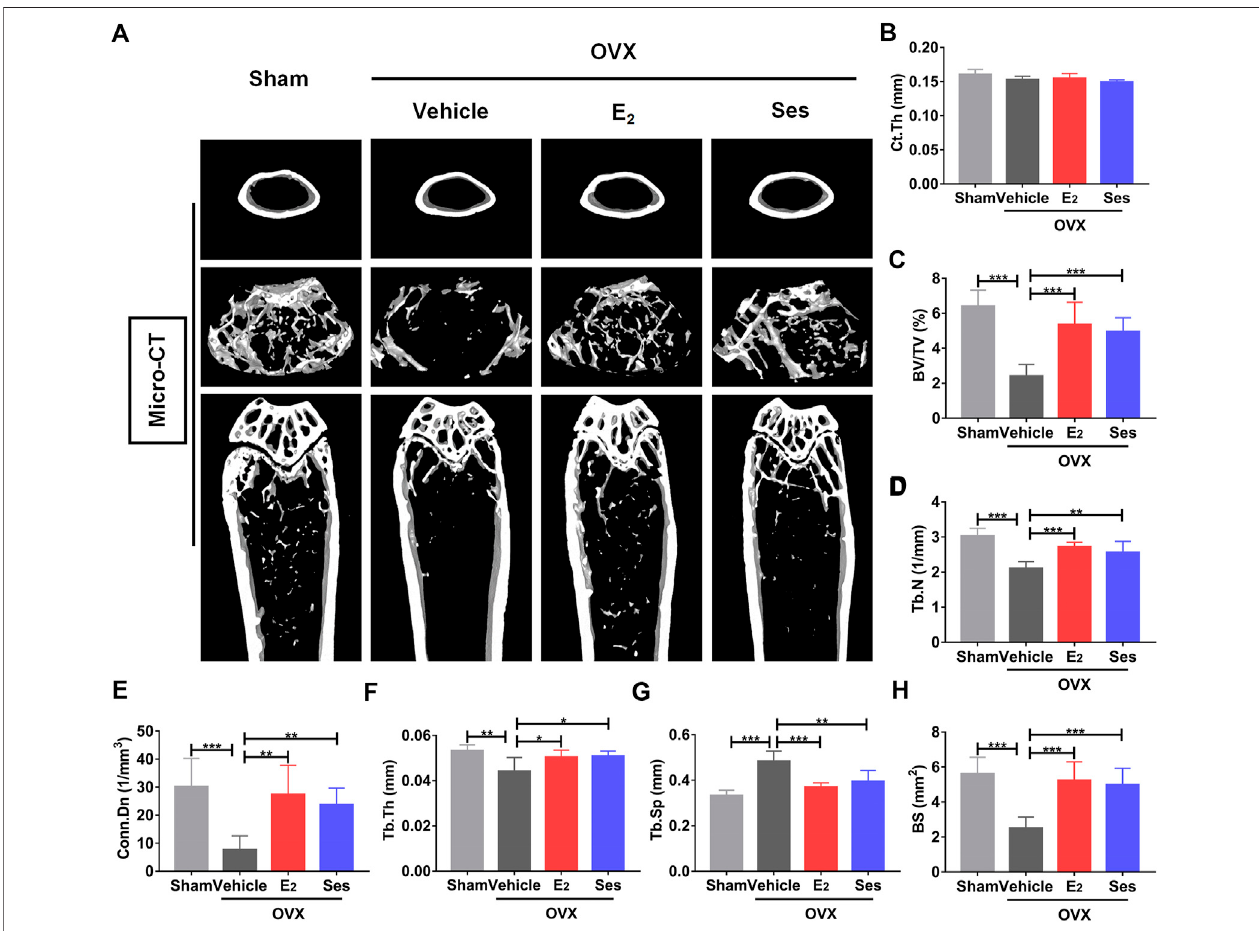
FIGURE 9| Ses treatment reduces bone loss in ovariectomized (OVX) mice. (A) Micro-CT showed that Sestreatment could prevent bone loss. (B – H) Quantitative analysisofbone-relatedparameters,includingCt.Th,BV/TV,Tb.N,Conn.Dn,Tb.Th,Tb.Sp,andBS( n (cid:1) 6).Theabovedataareexpressedasthemean ± SD;* p <